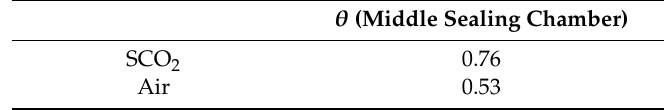
Table 5. Residual kinetic energy coefficient θ of SCO 2 and air flow at middle sealing chamber.